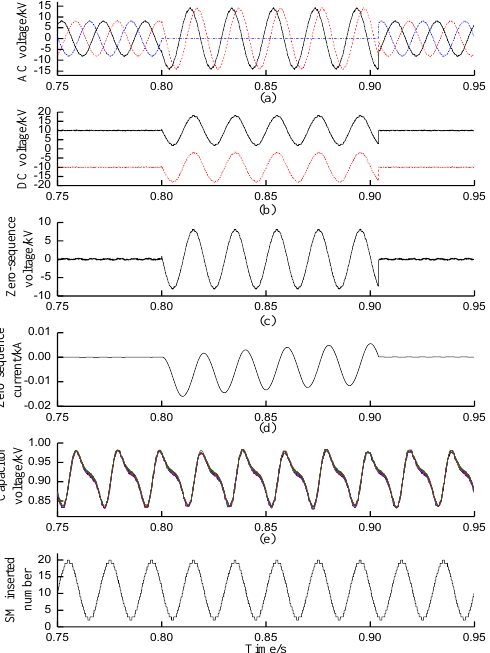
Figure 9. Fault response characteristics of MMC1 before optimization. ( a ) Three-phase AC voltage (blue is A-phase, black is B-phase, red is C-phase). ( b ) Positive and negative DC voltage (black is positive DC voltage, red is negative DC voltage). ( c ) AC zero-sequence voltage. ( d ) AC zero-sequence current. ( e ) SM capacitor voltage. ( f ) Inserted SM number of the upper arm in phase A on the MMC1.